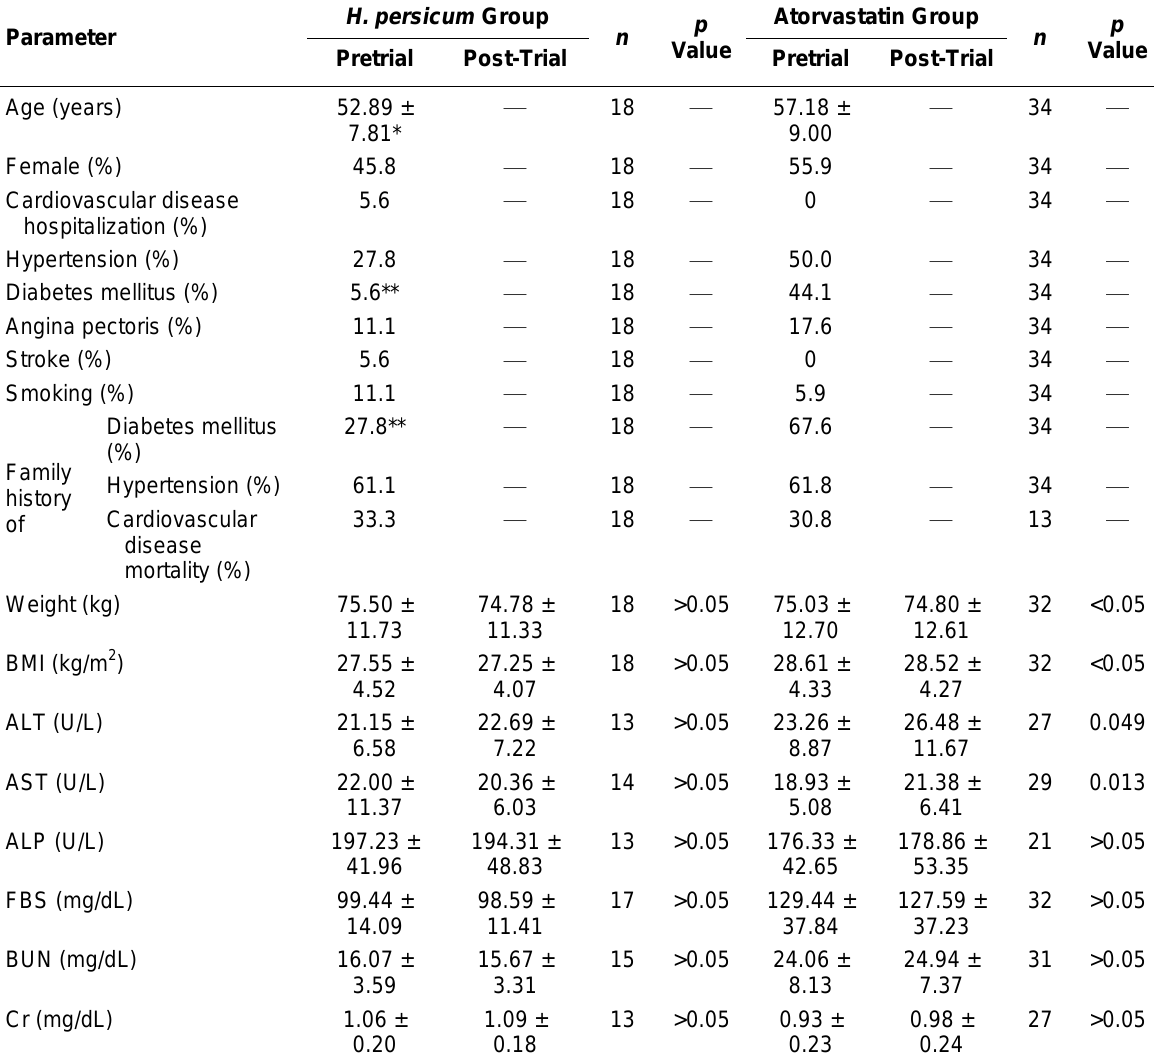
Clinical and Biochemical Characteristics of H. persicum and Atorvastatin Groups